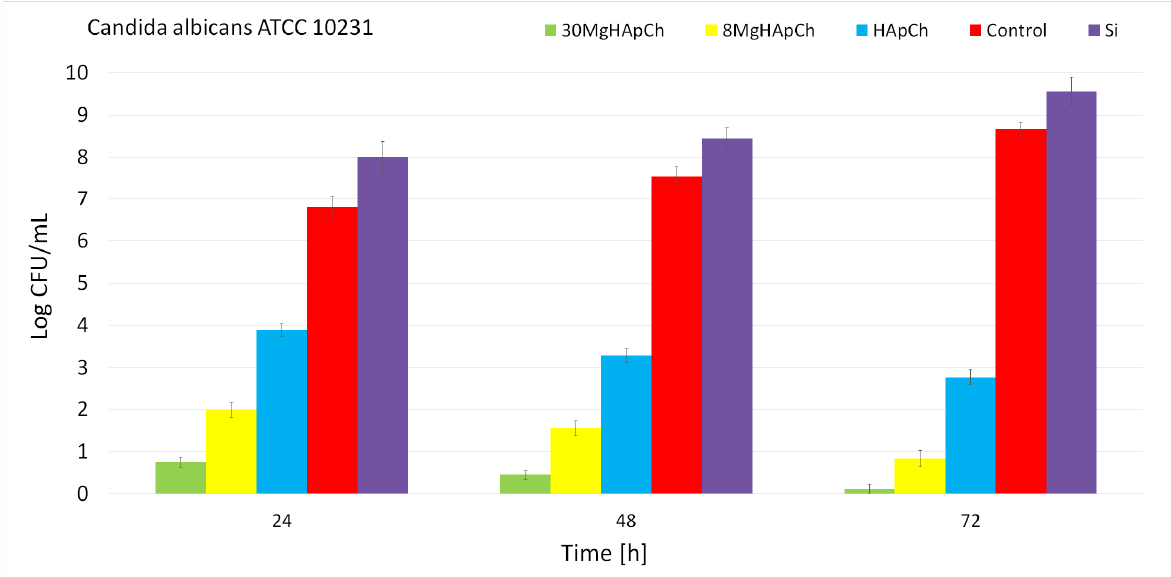
Figure 11. The antifungal properties of Si discs, HApCh, 8MgHApCh and 30MgHApCh composite layers against C. albicans (ATCC ® 10231) fungal cells after 24, 48 and 72 h of incubation.